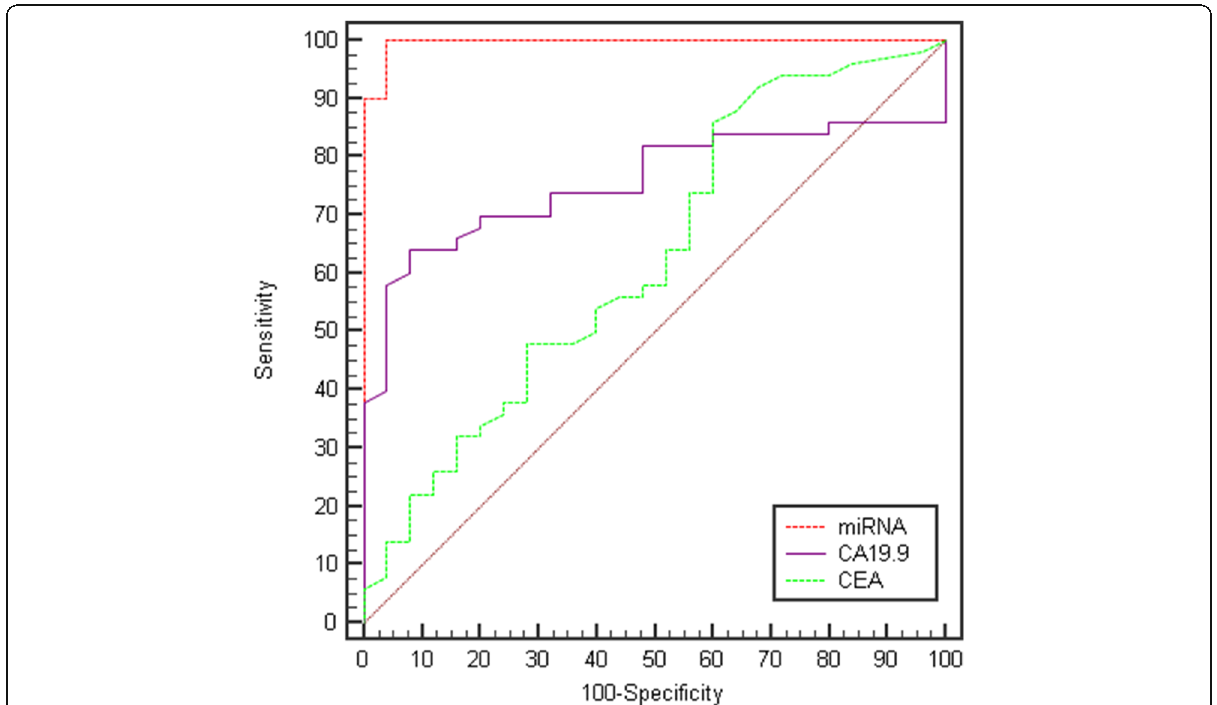
Fig. 1 ROC curve analysis to predict patients vs